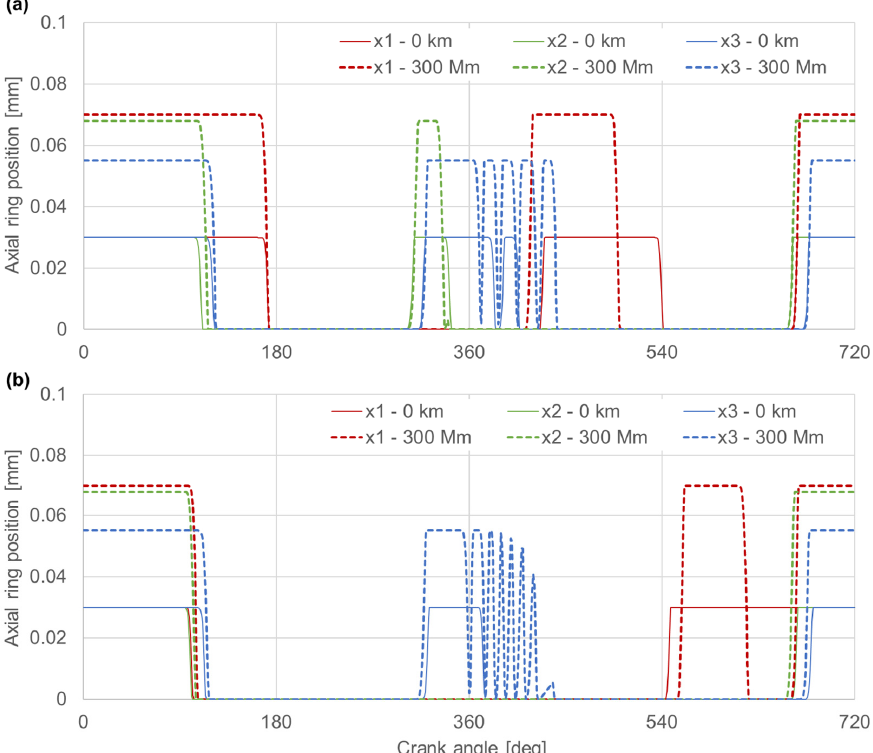
Figure 10. Axial displacements of the rings in the grooves for different wear and loads: ( a ) engine load 20 Nm; ( b ) engine load 168 Nm.